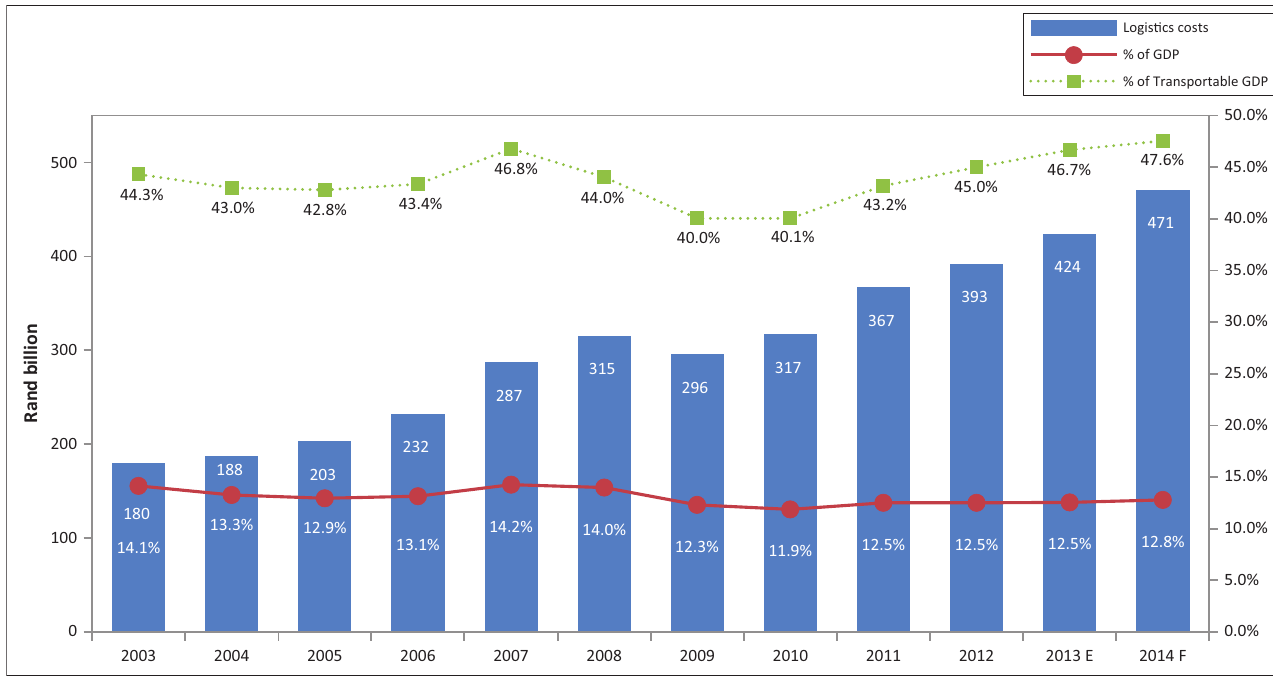
E, estimated; F, forecast; GDP, gross domestic product. FIGURE 4: South African logistics costs as a percentage of total and transportable gross domestic product.